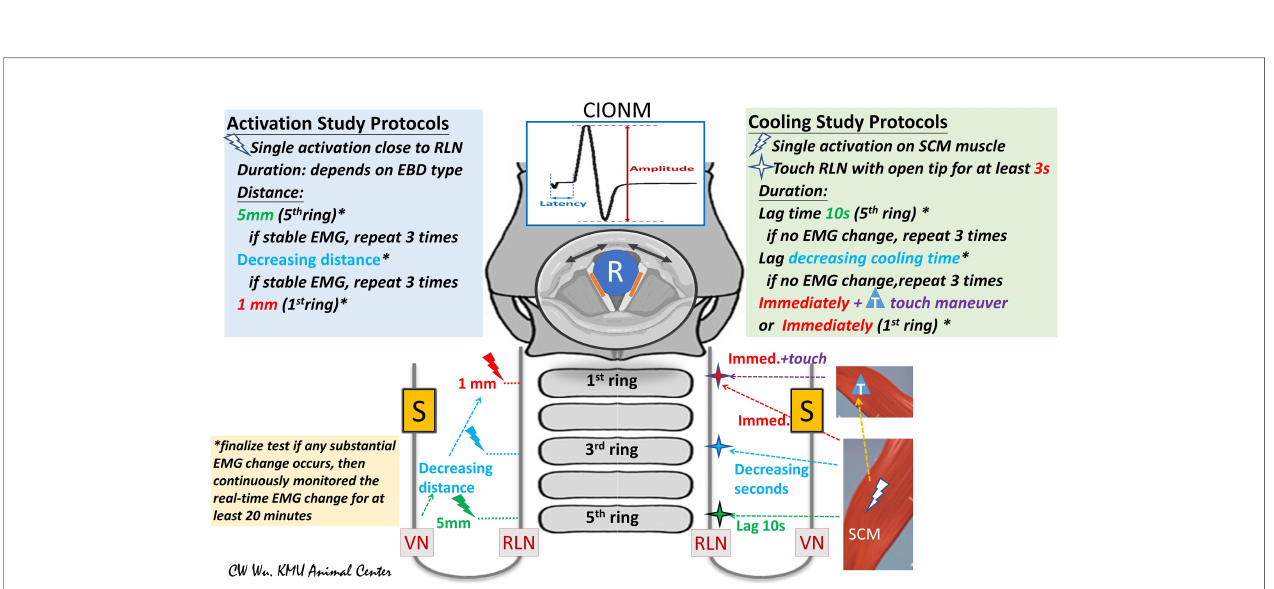
FIGURE 2 | Flowchart of study protocols for using energy-based devices (EBDs). (Left) Activation Study Protocols: Tests were performed from the proximal to distal segments of the RLN. The distance from the tip of the EBD to the RLN was measured. In this study, the fi rst test was performed at a distance of 5 mm from the fi fth tracheal ring. If the EMG remained stable after three tests, further tests were performed at a shorter distance. If the EMG remained stable after repeated tests, further tests were performed at a distance of 1 mm or with the EBD tip in direct contact with the RLN. (Right) Cooling Study Protocol: Tests were performed on the RLN from the proximal to distal segment. After a single EBD activation on the SCM muscle, the operator touched the RLN with the tip of the open blade after varying cooling times. The fi fth tracheal ring was touched after a cooling time of 10 seconds. If EMG remained stable in three tests, tests proceeded from the proximal RLN ( fi fth tracheal ring, green cross) to the distal RLN ( fi rst tracheal ring, red cross) after progressively decreasing cooling times. *asterisk: If a substantial EMG change was noted, the RLN experiment was considered complete, and EMG was continuously monitored for at least 20 minutes. T, touch maneuver: cooling by quickly touching surrounding tissue. S, Stimulation electrode for automatic periodic stimulation (APS) of vagus nerve (VN); R, Recording electrode on endotracheal tube for recording electromyography (EMG) signals evoked by vocal cord movement (black arrow); cIONM, continuous intraoperative neuromonitoring; RLN, recurrent laryngeal nerve; VN, vagus nerve; EBD, energy-based device; SCM, sternocleidomastoid; EMG, electromyography.